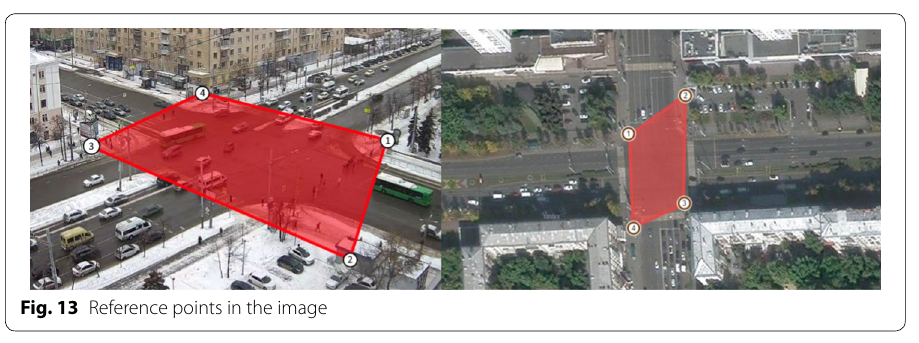
Fig. 13 Reference points in the